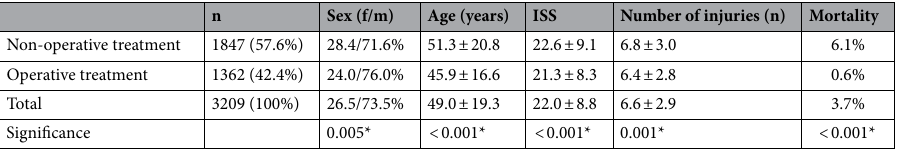
Table 1. Basic characteristics. ISS injury severity score; number of injuries, conditions that coexisted at the time of admission and caused by the trauma. *p < 0.05.